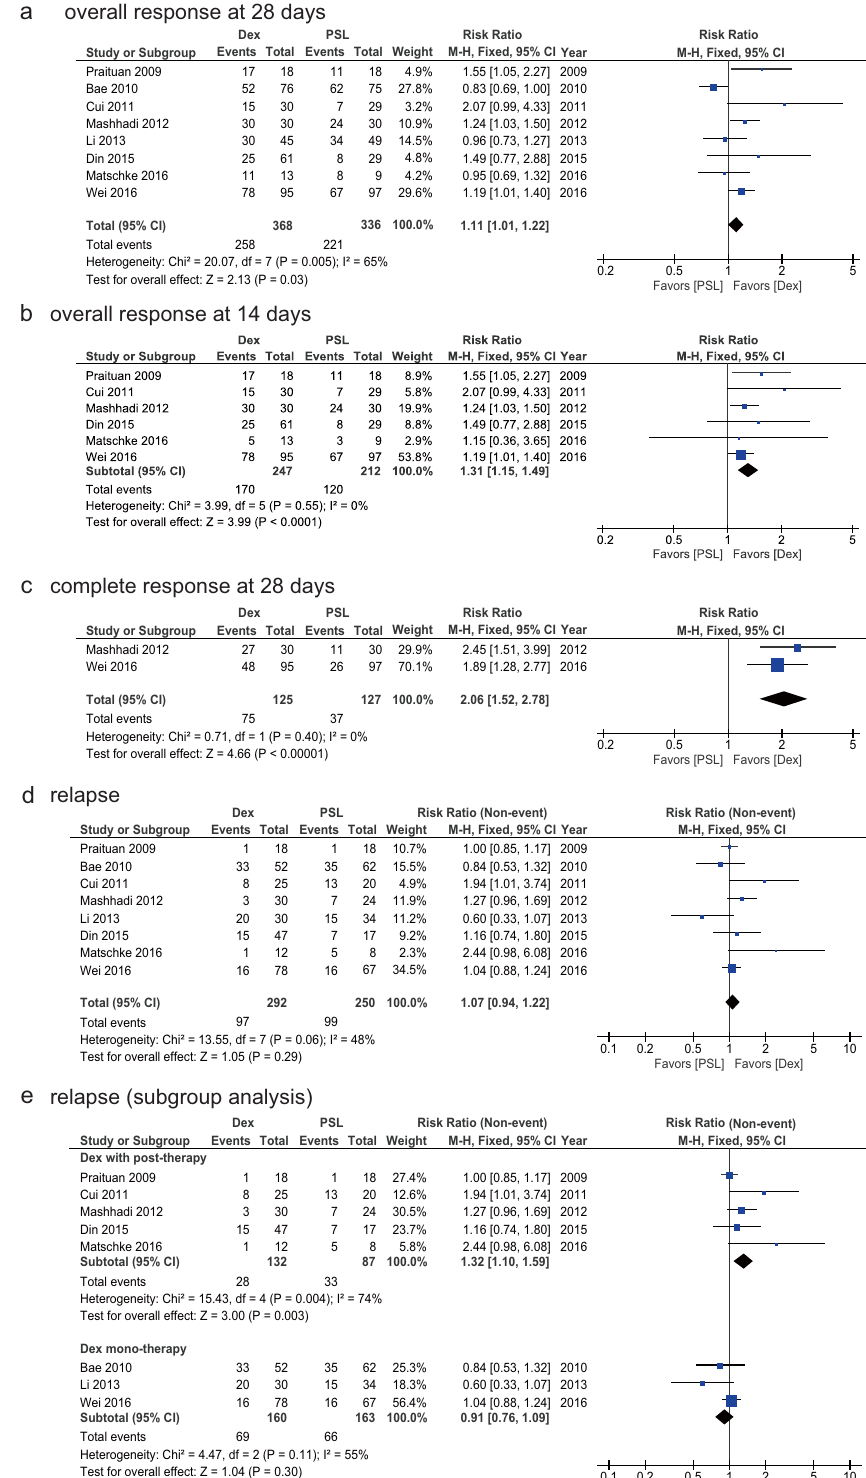
Fig. 2 Forest plots of short-term overall response (OR), complete response (CR), and relapse comparison. The summary effect estimate (risk ratio [RR] of overallresponse [OR;platelet counts > 30 (cid:1) 10 9 /L] andcompleteresponse [CR;platelet counts > 100 (cid:1) 10 9 /L] at28 or14daysafter theinitial therapy) forindividualrandomizedcontrolledtrials(RCTs;dexamethasone[Dex]vs.prednisolone[PSL])areindicatedwithblackboxes(theirsizesareproportionalto thestudyweight),withthelinesindicating95%con fi denceintervals(CIs).Theoverallsummaryeffectestimate(RR)and95%CIareindicatedbythediamond below for OR at 28 days ( a ) and 14 days ( b ), and CR at 28 days ( c ). Risk ratio of nonevent regarding posttherapeutic relapse (loss of response or bleeding episodes) was indicated in all RCTs ( d ) and in each subgroup regarding the addition of posttherapy in the Dex arm ( e ).